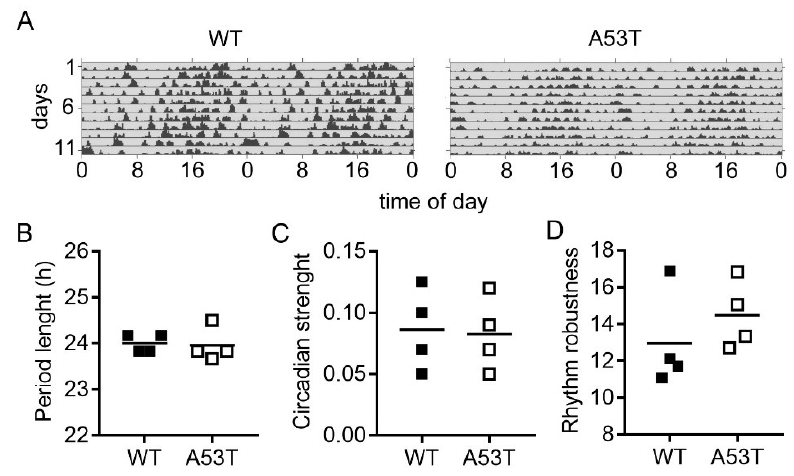
Figure 2. Analysis of locomotor activity and rhythm robustness in constant darkness. ( A ) Representative double-plotted actograms of spontaneous locomotor activity of WT and A53T mice in constant darkness. Grey shading indicates darkness; ( B ) Major peak in the period length based on Chi-square periodograms; ( C ) Circadian strength based on Fast Fourier analysis; ( D ) Rhythm robustness based on Qp analysis. There were no significant differences (Mann–Whitney test) in any of these parameters between WT and A53T mice.